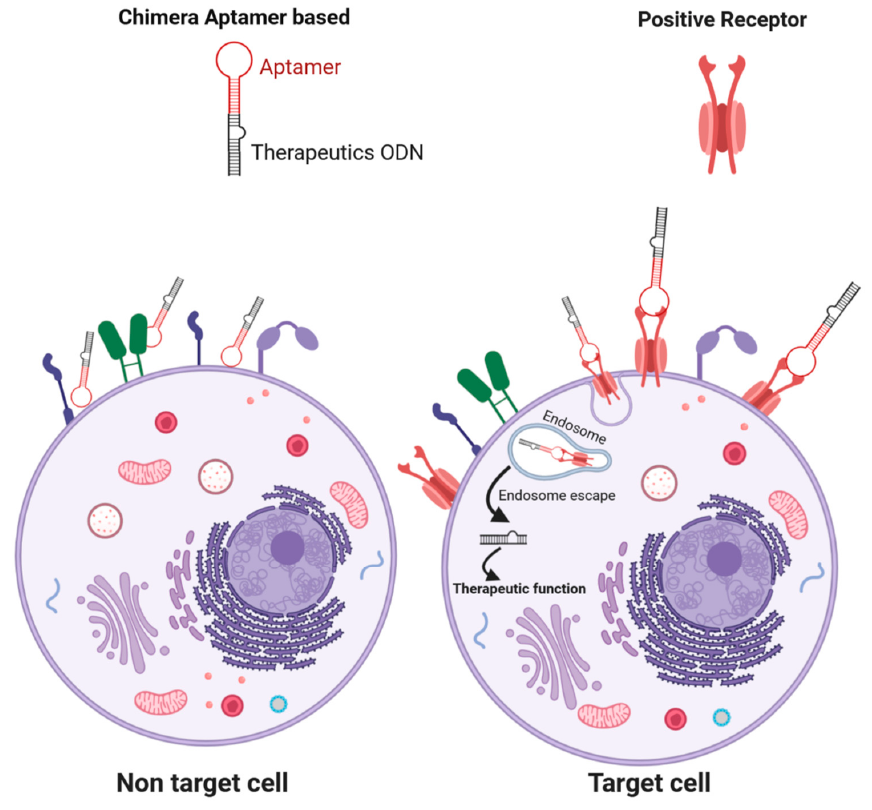
Figure 2. Aptamers deliver ODN. A Schematic design of binding and internalization strategy for ODN delivery.